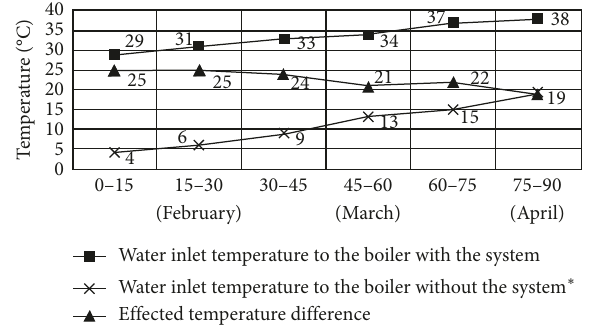
Figure 6: Water temperature entering the boiler with and without the